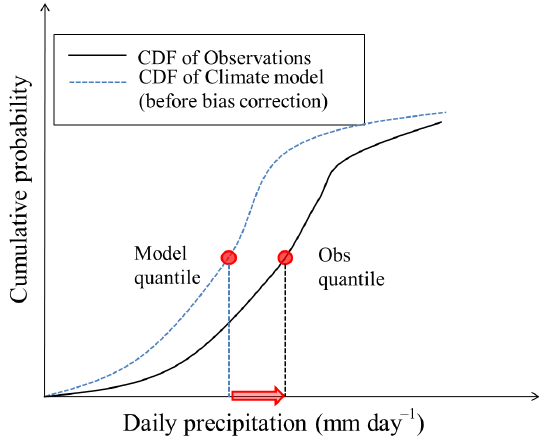
Figure 2. A schematic representation of the concept of the conven- tional quantile mapping method for bias correction.